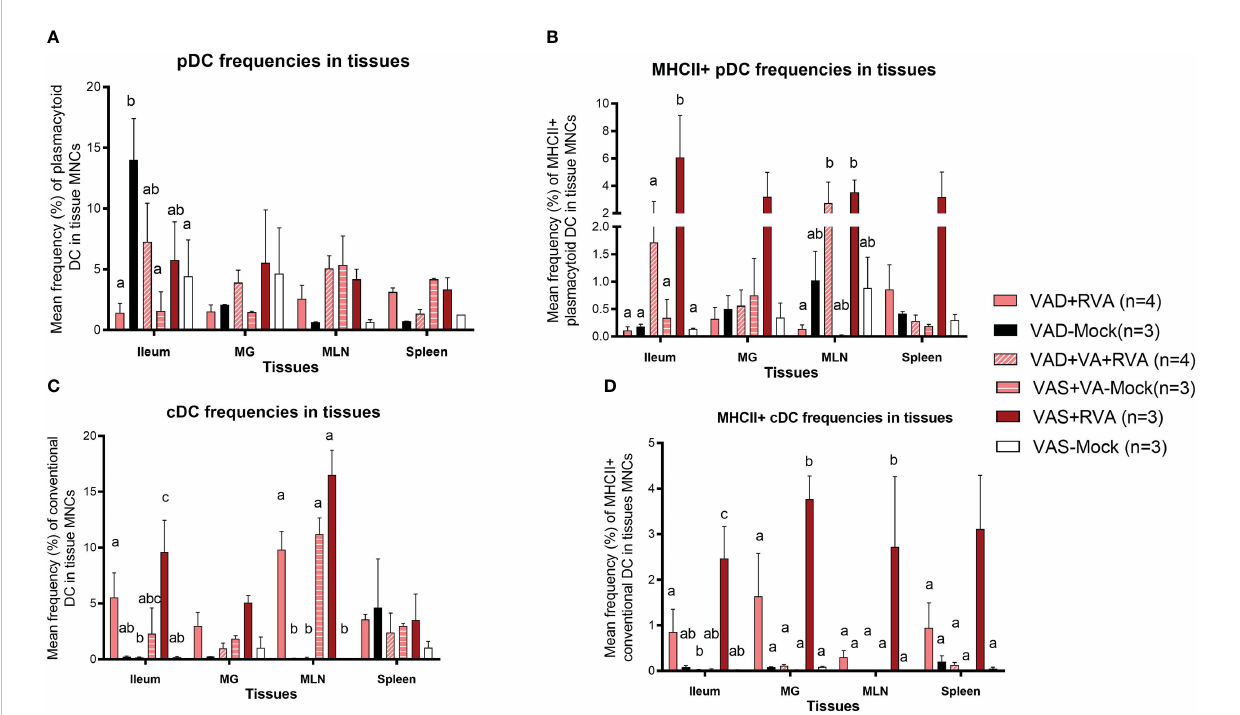
FIGURE 4 Analysis of different subsets of pDCs and cDCs in local and systemic tissues by fl ow cytometry. Ileum, MG, MLN, and spleen were collected at ~DPP21 (Euthanasia) and mononuclear cells were isolated. Mononuclear cells were analyzed by fl owcytometry. (A) Mean frequencies of total plasmacytoid DCs in tissue mononuclear cells. (B) Mean frequencies of MHCII + plasmacytoid DCs in tissue mononuclear cells. (C) Mean frequencies of total conventional DCs in tissue mononuclear cells. (D) Mean frequencies of MHCII + conventional DCs in tissue mononuclear cells. Letters a, b and c indicate signi fi cant differences among treatment groups (mean ± SEM) at each time point. Statistical analysis was performed using two-way ANOVA with repeated measures and Tukey-Kramer test for multiple comparisons, P ≤ 0.05. (GD, gestation day; DPP, day post-partum; VAD, vitamin A de fi ciency; VAS, Vitamin A suf fi cient; VA-vitamin